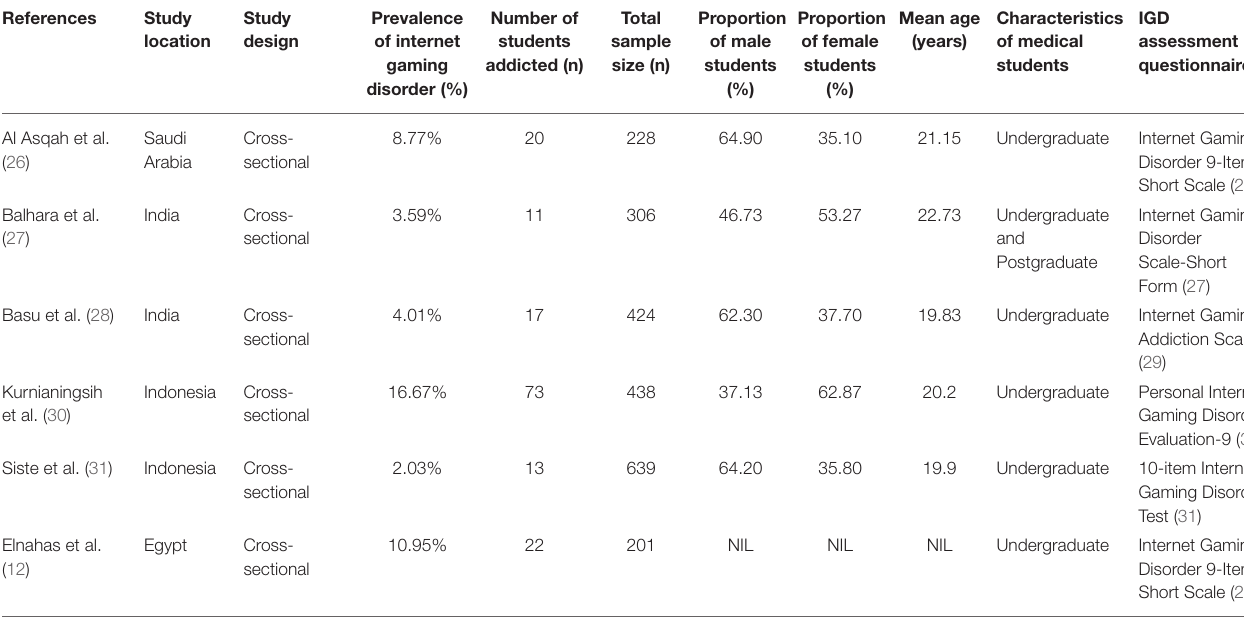
TABLE 1 | Baseline characteristics of studies